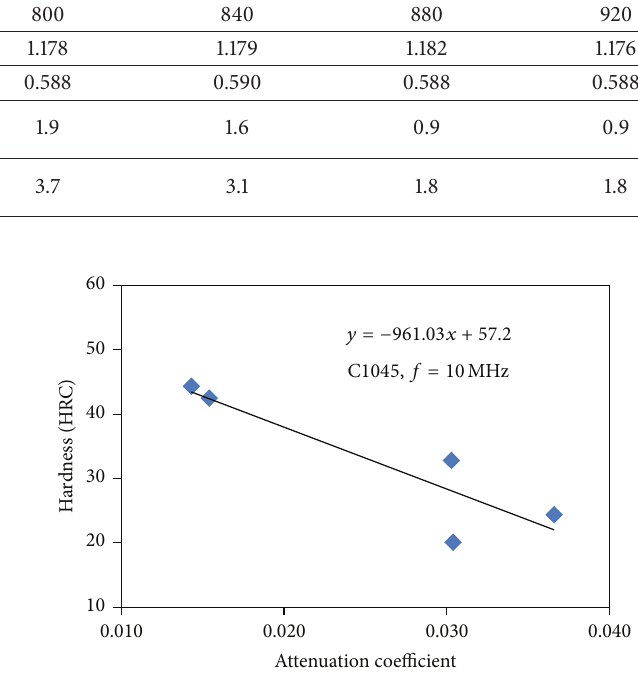
Figure 11: Relationship of attenuation coefficient and hardness at different heat treatment temperatures using